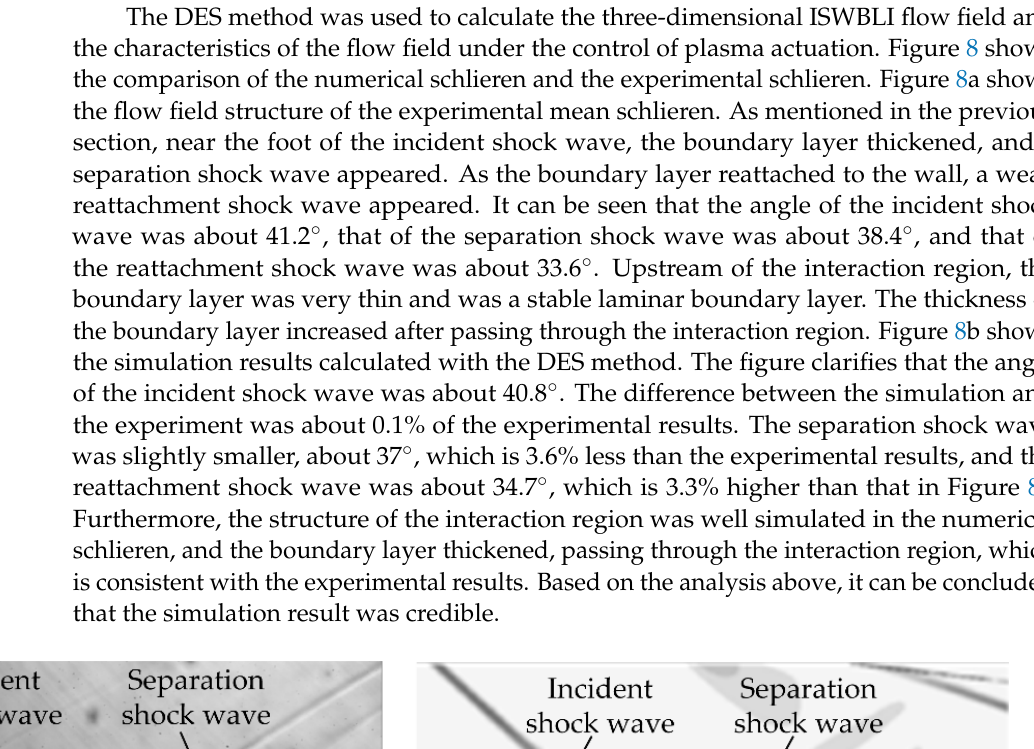
Figure 7. Model grid and boundary conditions.